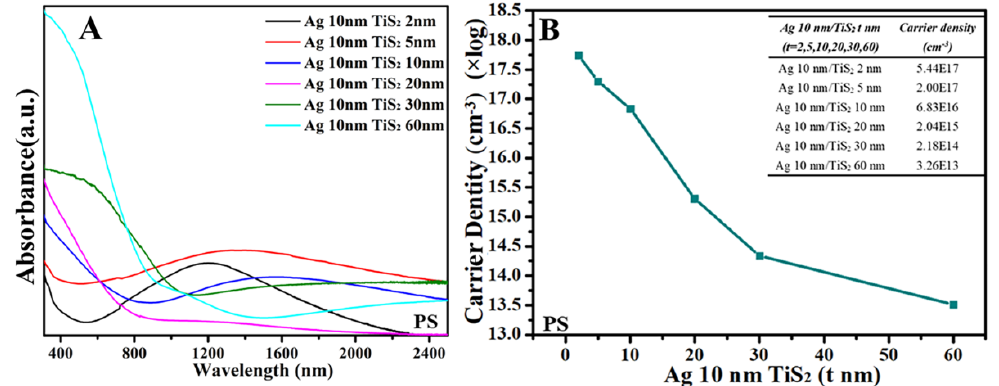
Figure 5. ( A ) UV–Vis–NIR spectra and ( B ) Hall effect for the Ag 10 nm/TiS 2 (t = 2, 5, 10, 20, 30, 60 nm) nanostructures on PS, and the table inset is the original data.